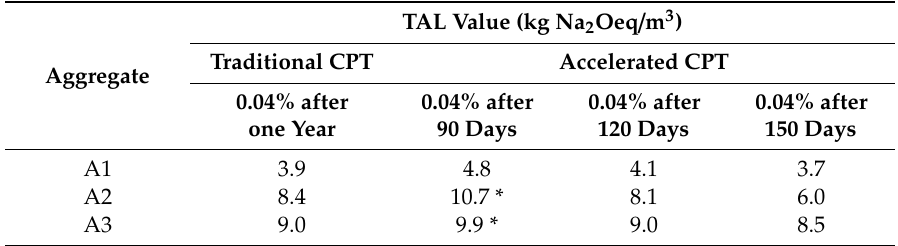
Table 5. Comparison between the TAL values of the three aggregates obtained from the traditional CPT and the accelerated CPT using different expansion limit criteria.